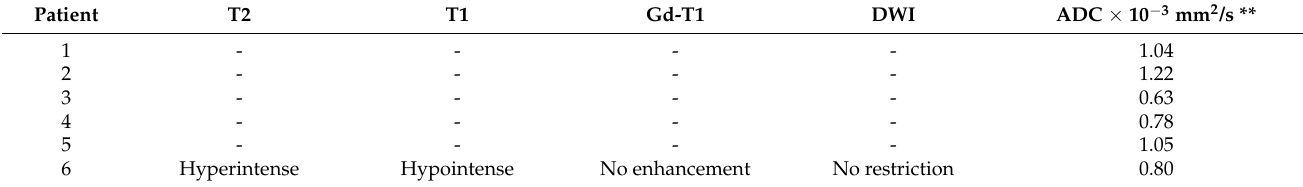
Table 8. MR imaging appearance * of necrosis of uveal melanomas in the nonirradiated